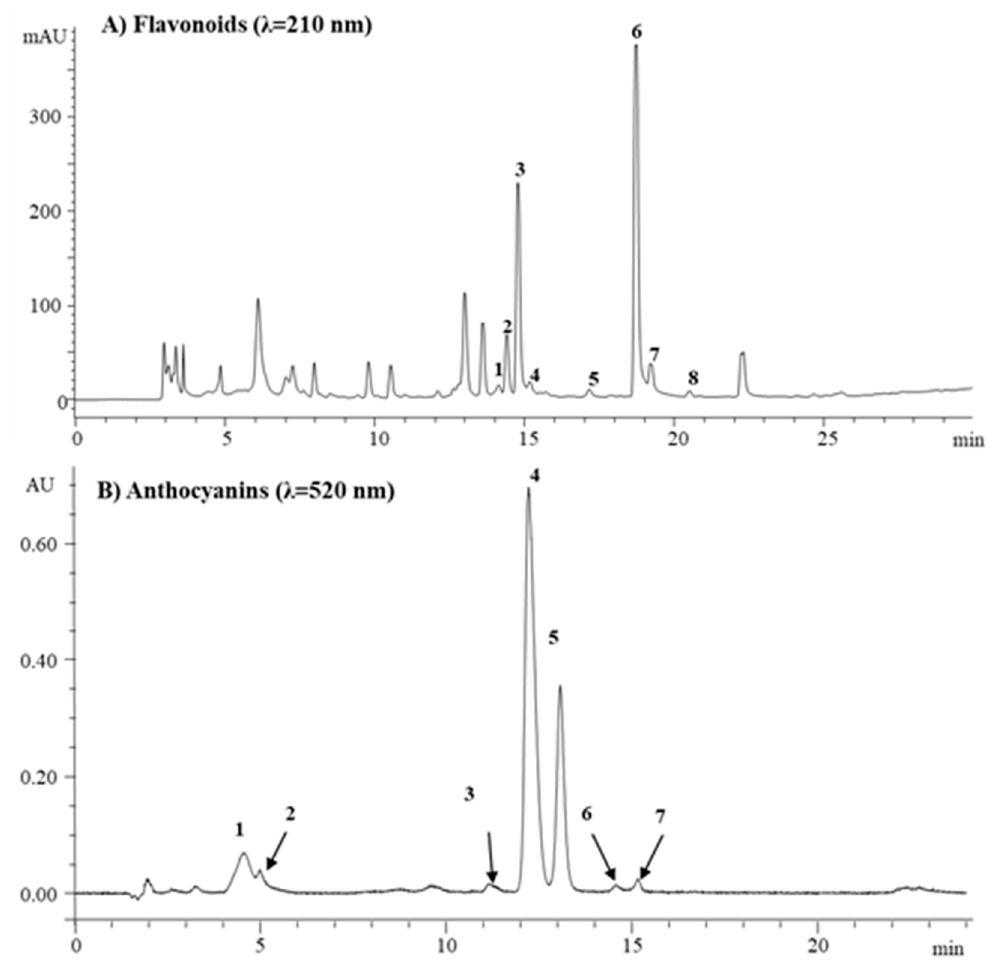
Figure 4. ( A ) Chromatogram of onion flavanoids. Components 1–8 were identified as follows: 1: Quercetin-3,7,4 ′ -triglucoside;